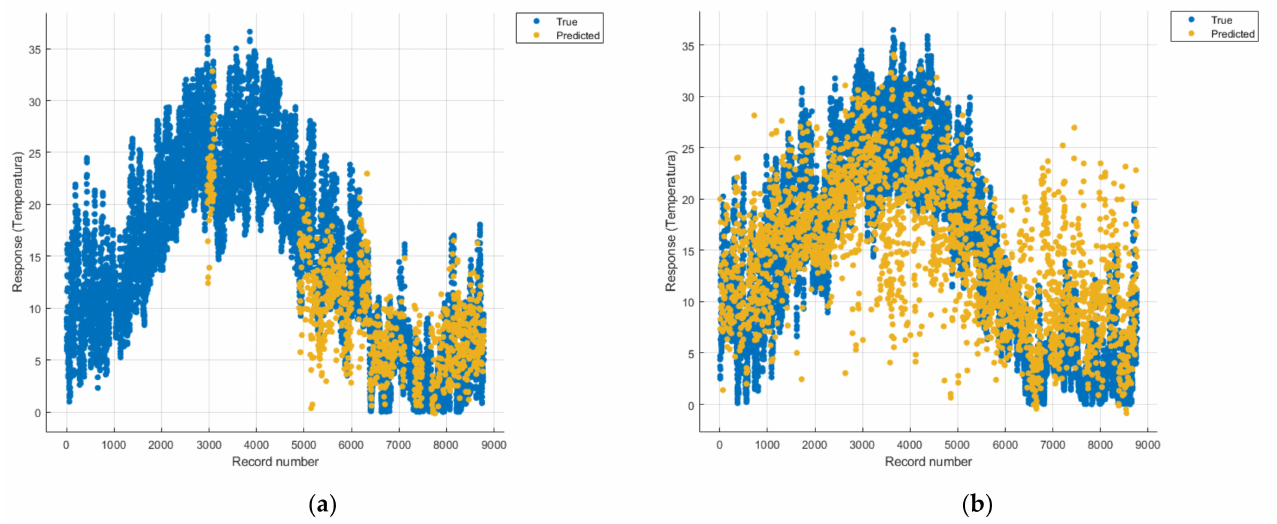
Figure 13. Prediction considering all pollutants—Fine Gaussian SVM. ( a ) March 2019–February 2020, ( b ) March 2020– February